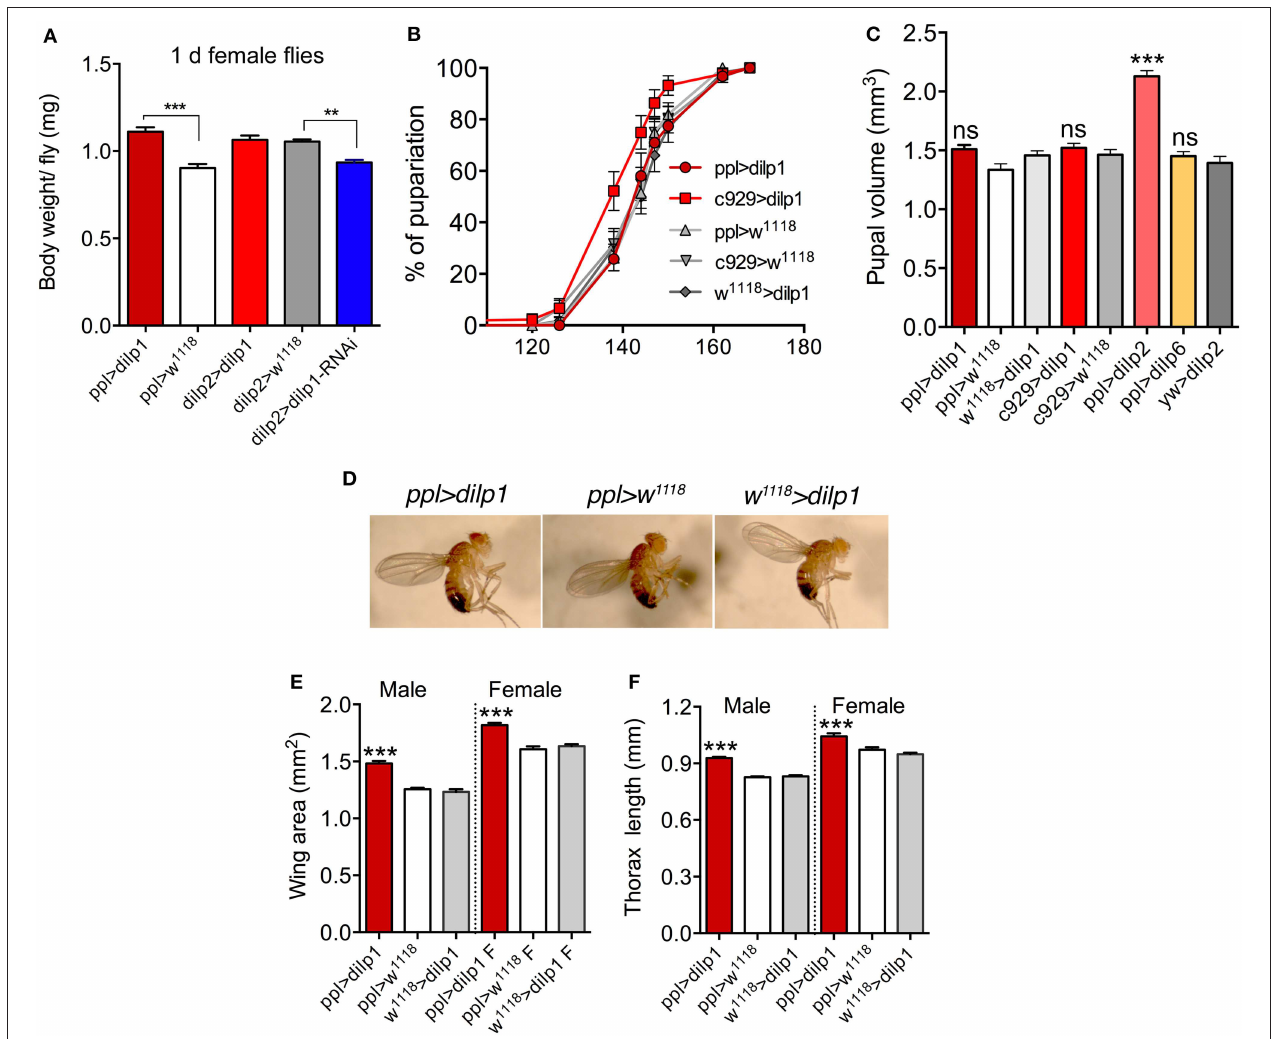
FIGURE 2 | Overexpression of dilp1 affects growth during pupal stage. (A) One-day-old female flies weigh more than controls in ppl > dilp1 flies, but not in dilp2 > dilp1 . Knockdown of dilp1 by dilp2 > dilp1 -RNAi leads to decreased body weight. Data are presented as means ± S.E.M, n = 20–27 flies for each genotype from three independent replicates (** p < 0.01, *** p < 0.001, unpaired Student’s t -test). (B) Overexpression of dilp1 in fat body ( ppl -Gal4) or neuroendocrine cells ( c929 -Gal4) does not affect time to pupariation (larval development). Data are presented as means ± S.E.M, n = 138–147 flies for each genotype from three independent replicates [assessed by Log-rank (Mantel-Cox) test]. (C) Overexpression of dilp1 using ppl -Gal4 or c929 -Gal4 does not affect pupal volume (proxy for larval growth). Also dilp6 overexpression has no effect, whereas dilp2 expression triggers a significant increase in pupal volume. Data are presented as means ± S.E.M, n = 15–32 flies for each genotype from three independent replicates (*** p < 0.001, ns, not significant; one-way ANOVA followed with Tukey’s test). (D) Images of flies overexpressing dilp1 in the fat body and controls. (E,F) Overexpression of dilp1 in fat body results in flies with increased wing area (E) , and length of